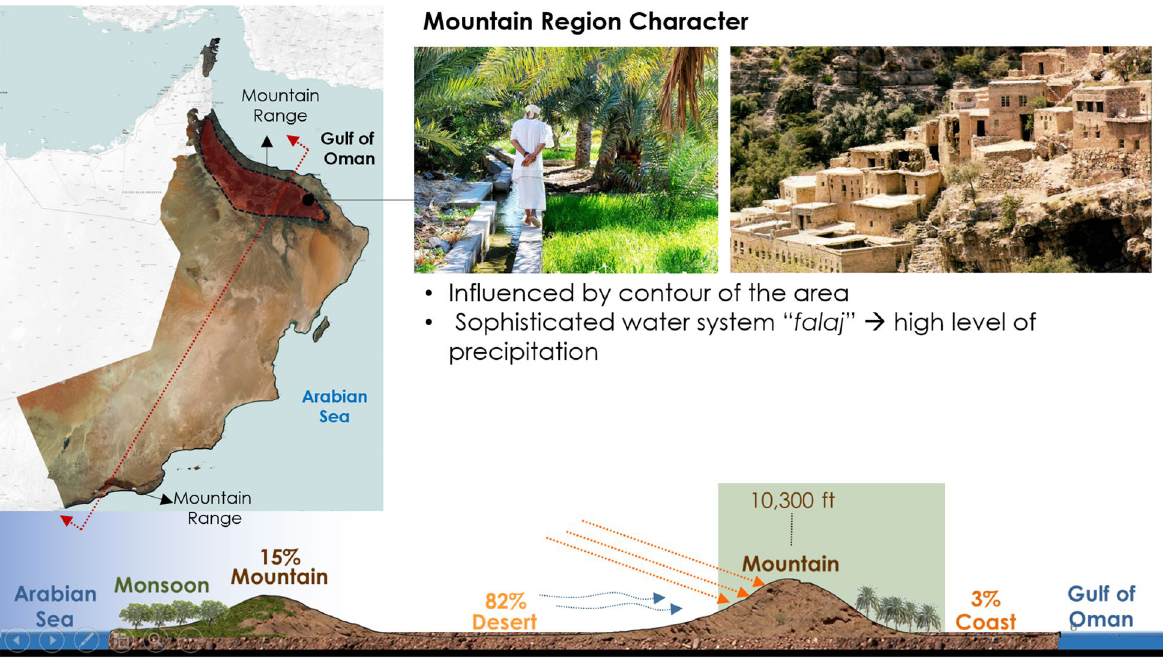
Fig. 1 Geographic layout of Oman, highlighting the mountainous region (Source: Benkari, Naima, and Alya Al-Hashim: Omani traditional houses and settlements: a new options for developing a sustainable tourism,